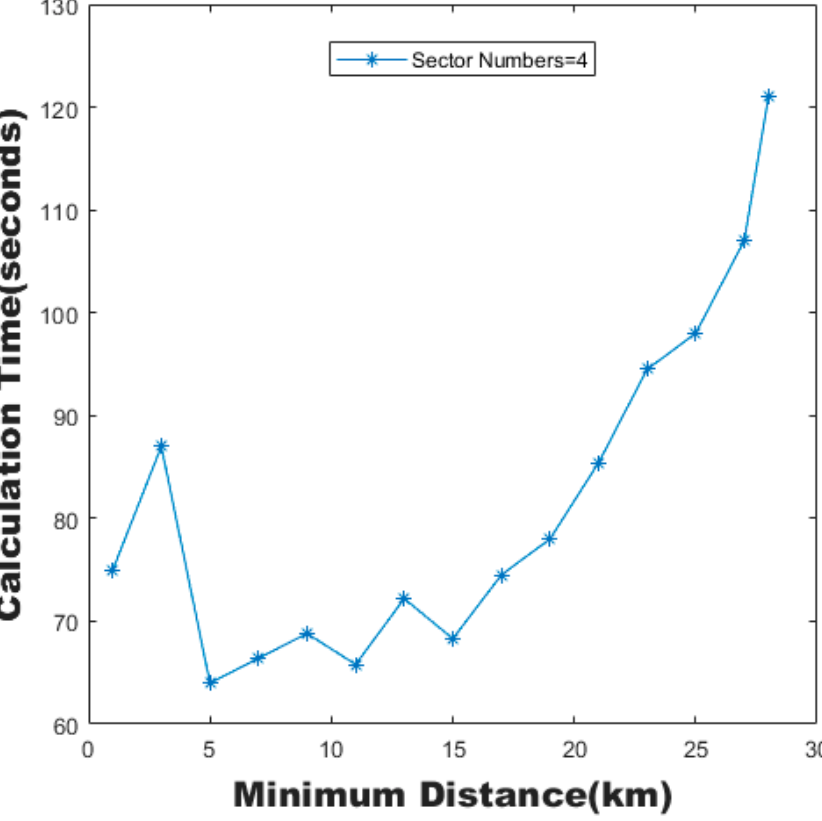
Figure 23. Calculation time of the MC-CLFV algorithm with different minimum distances.